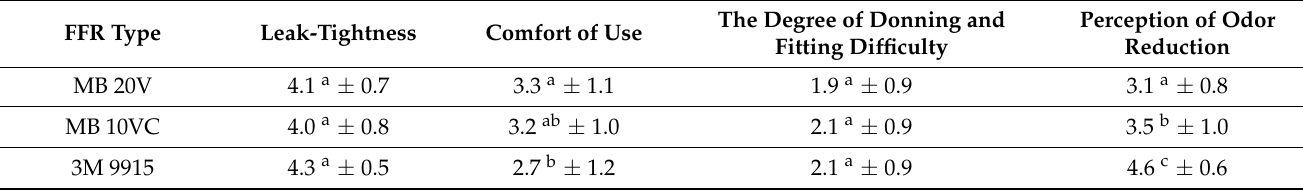
The Degree of Donning and Perception of Odor Fitting Difficulty Reduction